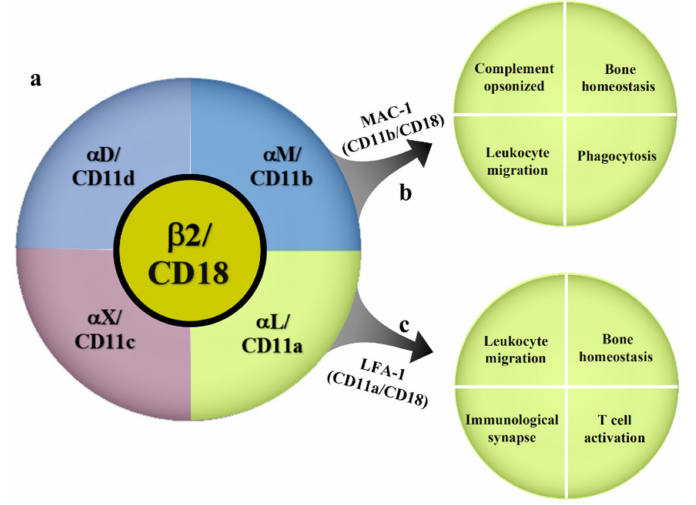
Figure 1. Classification of β 2 integrins and the major cellular functions of LFA-1 and Mac-1. a. β 2 integrins exist as a combination of a β 2/CD18 subunit and four different α subunits. b. Mac-1 consists of α M/CD11b and β 2/CD18. It modulates the complement-opsonized bone homeostasis, leukocyte migration, and phagocytosis. c. LFA-1 consists of α L/CD11a and β 2/CD18. It regulates the leukocyte migration, bone homeostasis, immunological synapse, and T-cell activation.